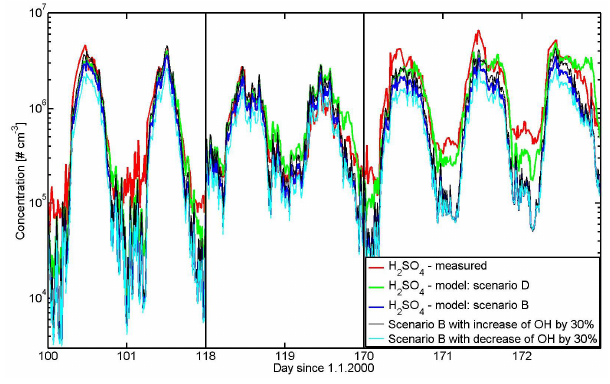
Fig. 6. Measured and modelled sulfuric acid concentrations for Ho- henpeissenberg; the definitions of the different model scenarios are presented in Sect. 3.3.